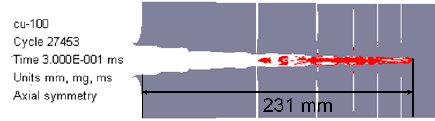
Figure 14. Penetration performance of the single copper jet ( b 1 = 0) at standoff of 1.0 CD.